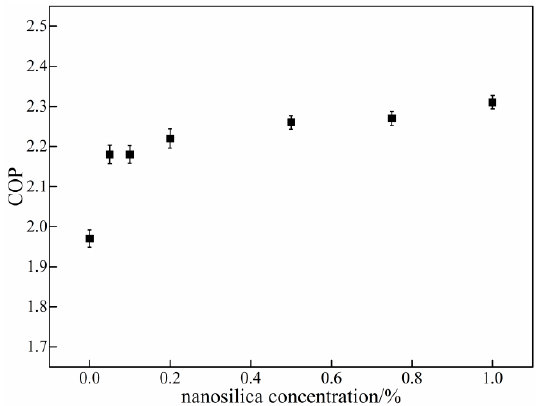
Figure 16. Effects of nanosilica concentration on COP.